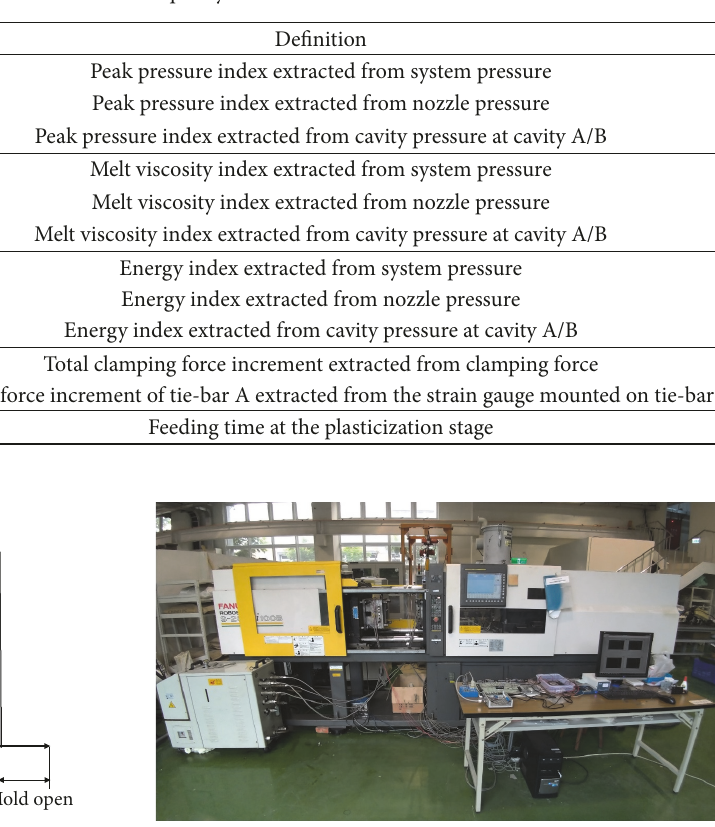
Table 1: Abbreviations of quality indexes.